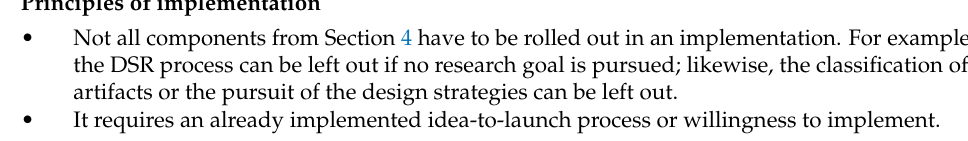
Table 5. Cont. Design Theory Components and Method-specific Elements Principles of